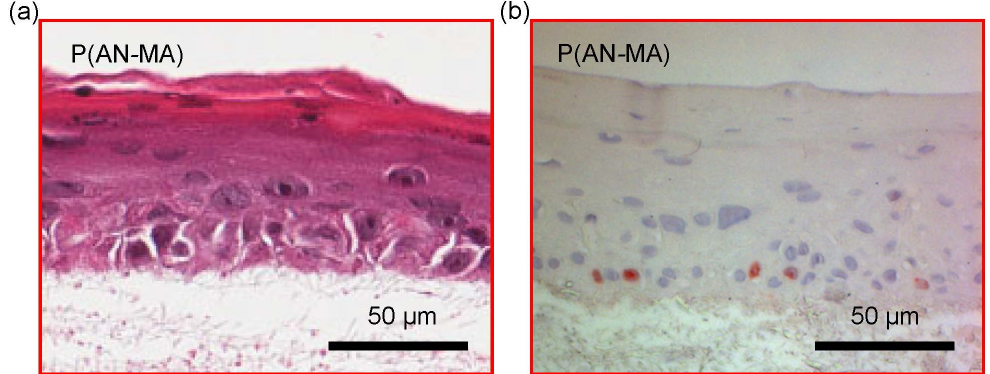
Figure 8. H/E and Ki-67 staining of the 3D skin cell model showing stratified epidermis-like structures and proliferating keratinocytes on P(AN-MA) electrospun nanofiber mats. ( a ) H/E staining, ( b ) Ki-67 staining of proliferating cells (red) in the epidermal part.